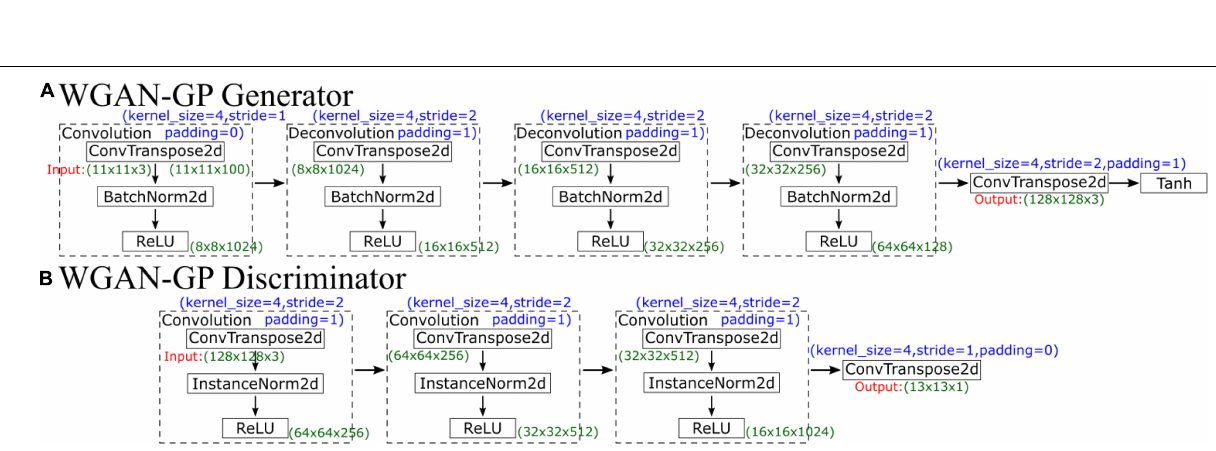
FIGURE 5 | Schematic diagram showing the (A) generator and (B) discriminator of WGAN-GP.